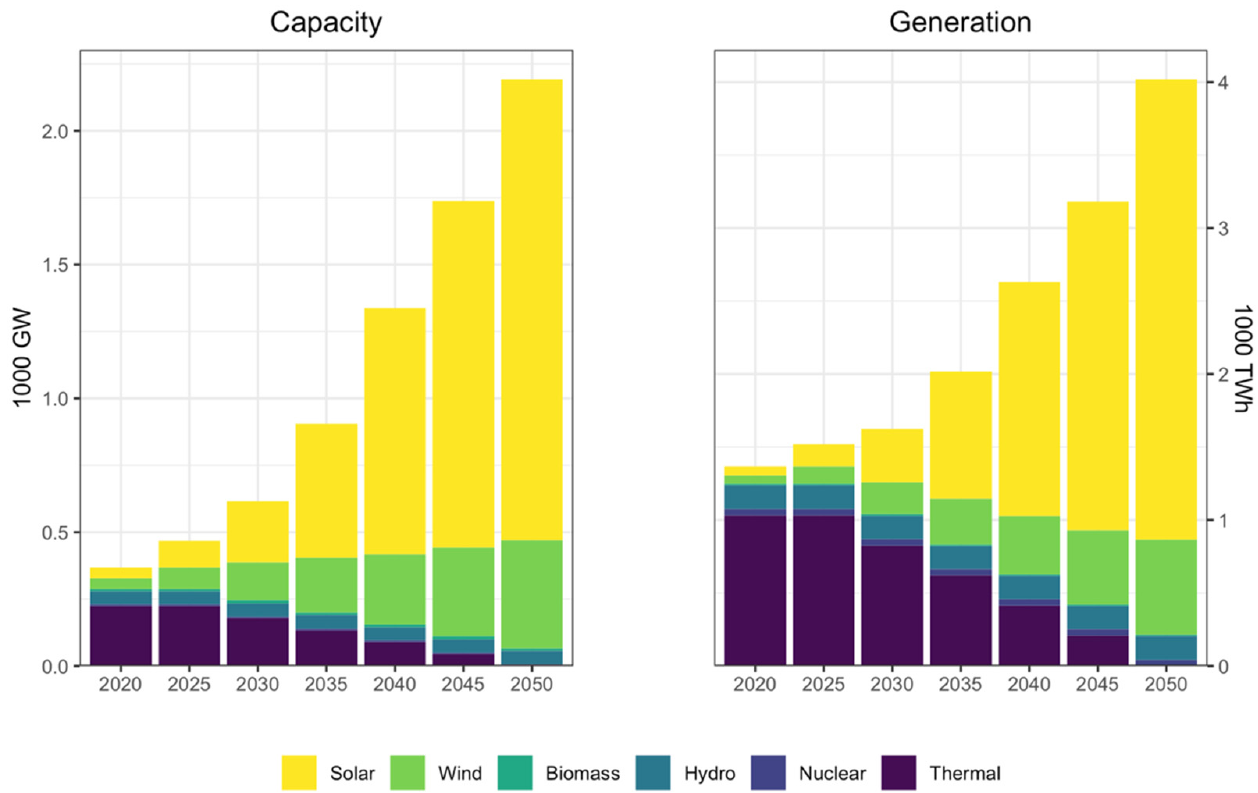
Figure 18. Dynamics of generating capacity and electricity generation in the transitional scenario.